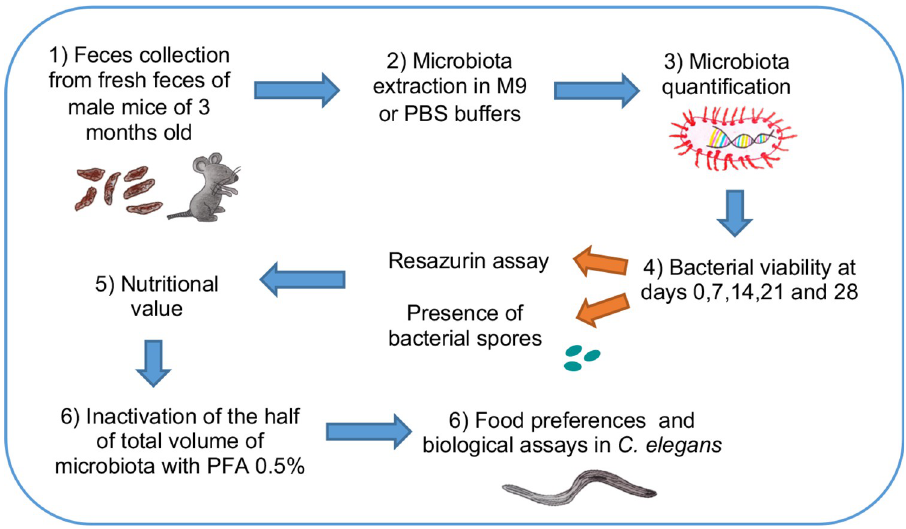
Fig 1. Outline of experimental design. Fresh feces are collected from mice. MCB homogenates are produced by immersing the feces in M9 or PBS buffers, and quantified by bacterial DNA analysis. Bacterial viability is then evaluated quantitatively by resazurin assay (Alamar blue) and qualitatively by the presence of spores (Schaeffer-Fulton staining). Nutritional value of the MCB is evaluated by quantifying energy metabolites (glucose, glycogen, triglycerides, and glycerol). Subsequently, half of MCB extract is inactivated with PFA and the other half is kept alive to allow symbiosis. Alive and inactivated MCB homogenates are then used to characterize phenotypes and biological traits in the nematode C . elegans